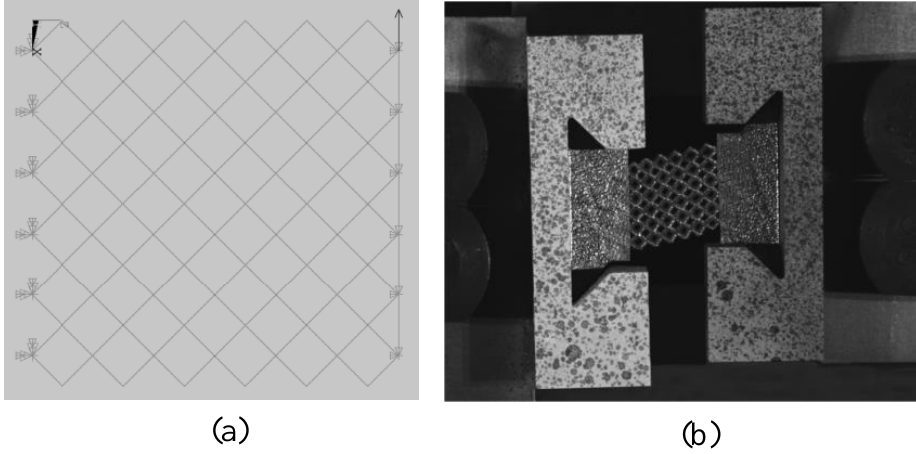
Figure 13. Deformation boundary conditions of the sandwich BCC lattice: ( a ) FE model; ( b ) sample.